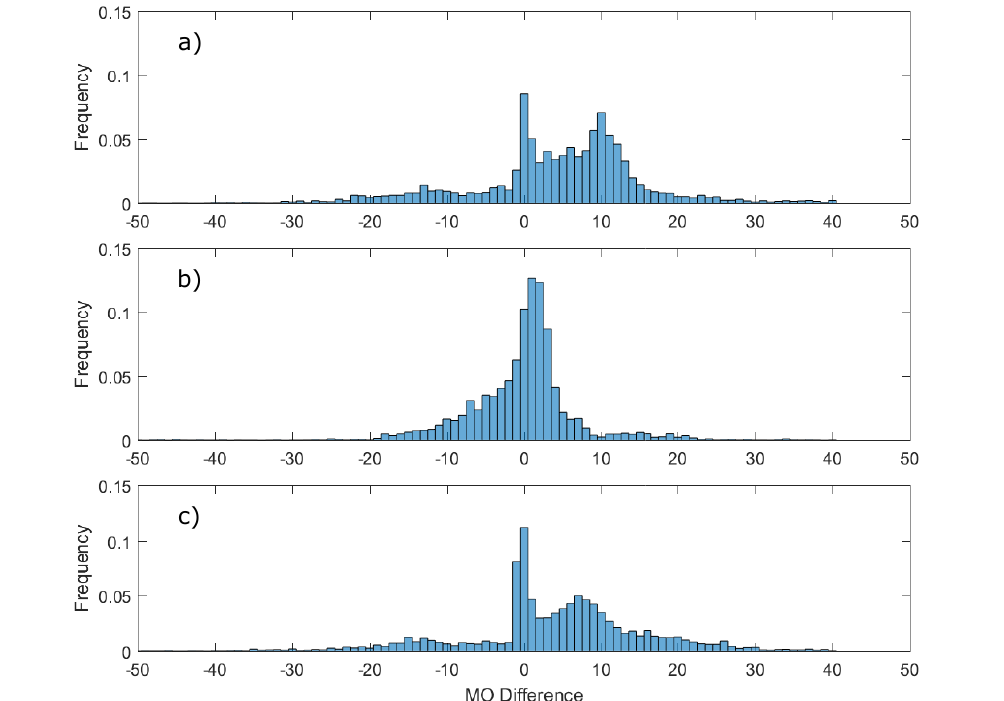
Figure 5. Normalized histogram of MO date differences by pixel for years from 2003 to